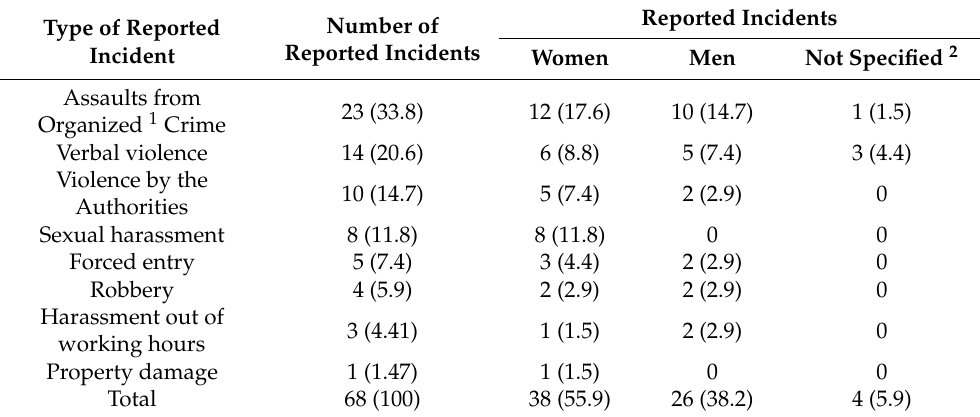
Table 1. Official report on the frequency of violence incidents of SSMIs, classified by sex. A total of 53 SSMIs (18 men, 33 women, and 2 who did not specify sex) reported a total of 68 incidents. Number of Reported Type of Reported Incident Incidents